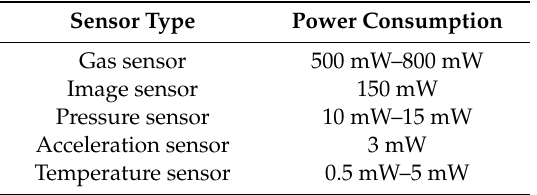
Table 1. Sensor types and their powering